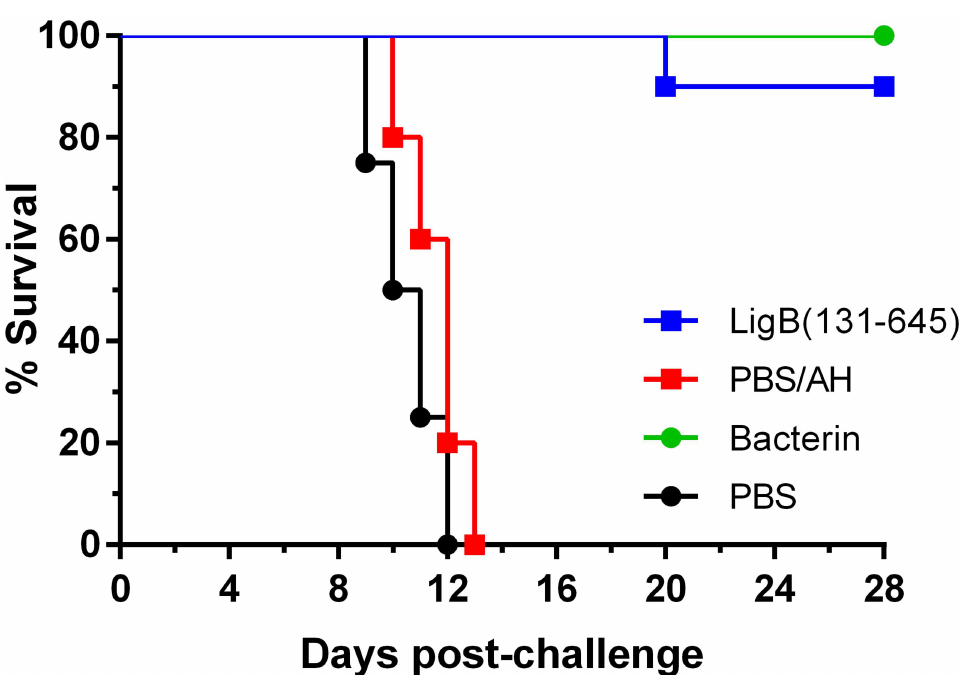
Fig 2. Protection against lethal challenge. Representative experiment of survival amonghamsters vaccinated with rLigB(131–645), bacterinor a PBS control, followedby the administration of a potentially lethal dose of L . interrogans serovar Copenhageni strain Fiocruz L1-130, see Table 1. Groups of hamsters were immunized (days -28 and -14) with two doses (80/40 μ g) of either rLigB(131–645)/AH; PBS/AH control; bacterin; or a PBS only control, and challengedwith 200 leptospires (day 0). The rLigB(131–645)/AHvaccine preparation significantly protected 90.0% (9/10) of hamsters againstchallenge( P < 0.001), compared to 100% (4/4) protection in hamsters vaccinated with the bacterin( P <